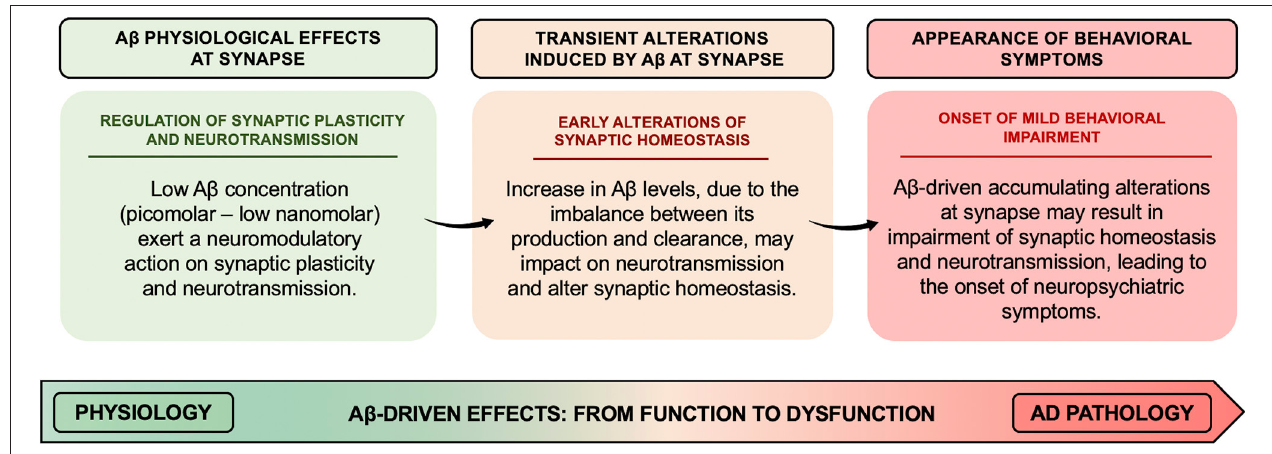
FIGURE 1 | A β -driven effects at synapse: the derangement from function to dysfunction. Low concentrations (picomolar–low nanomolar) of A β exert a neuromodulatory action on synaptic plasticity and neurotransmitter release from the presynaptic terminals. The alteration of A β homeostasis, due to an imbalance between A β production and clearance, may impact on the fine-tuning of synaptic vesicle cycling and neurotransmitter release, thus altering synaptic homeostasis. A β -driven accumulating alterations at synapse might result in permanent impairment of synaptic homeostasis and neurotransmission, thereby leading to the onset of neuropsychiatric symptoms frequently observed in the prodromal stage of